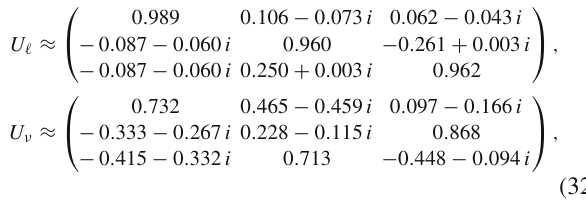
parameters and output of PMNS parameters at the best-fit point